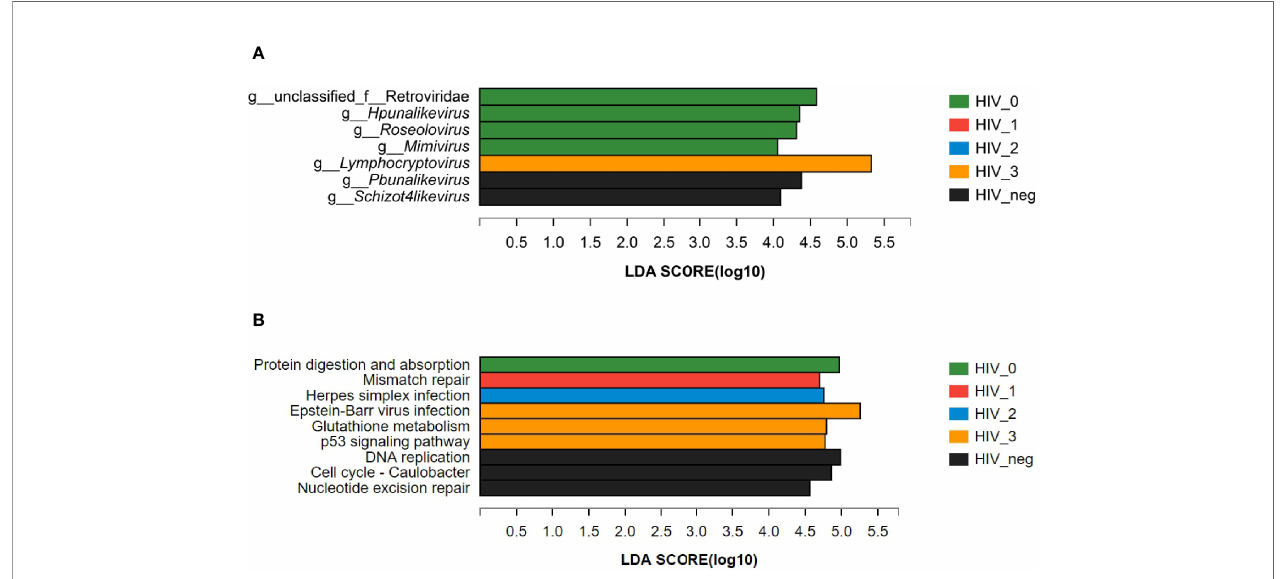
FIGURE 3 | LEfSe bar charts of differences between the HIV-positive groups and HIV-negative controls. (A) Differences in salivary viral abundances; (B) Differences in the salivary viral functions at KEGG Pathway Level